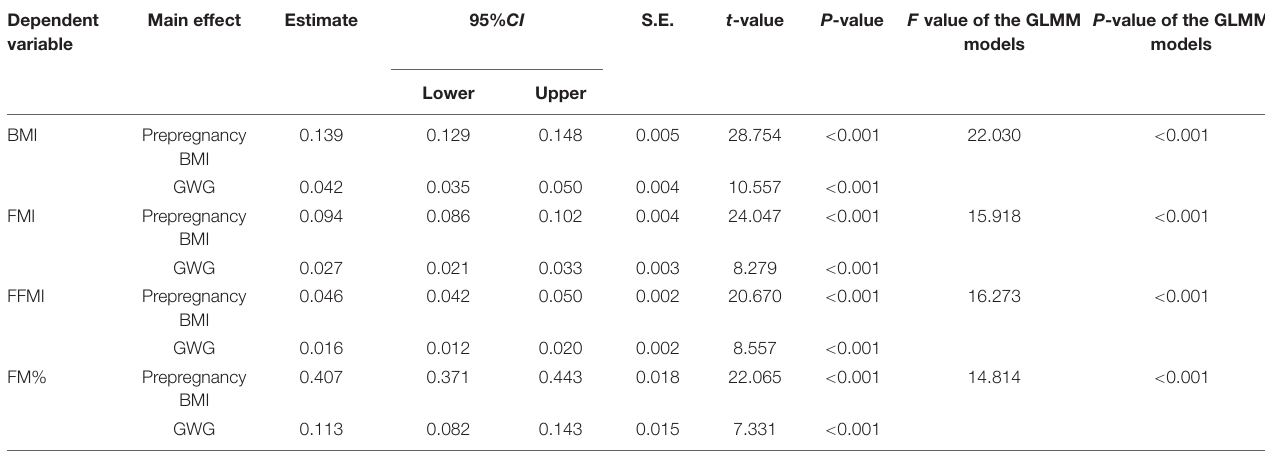
TABLE 3 | Generalized Linear Mixed Models (GLMMs) associations between prepregnancy BMI, GWG and the adiposity indicators in kindergarten children. Dependent variable